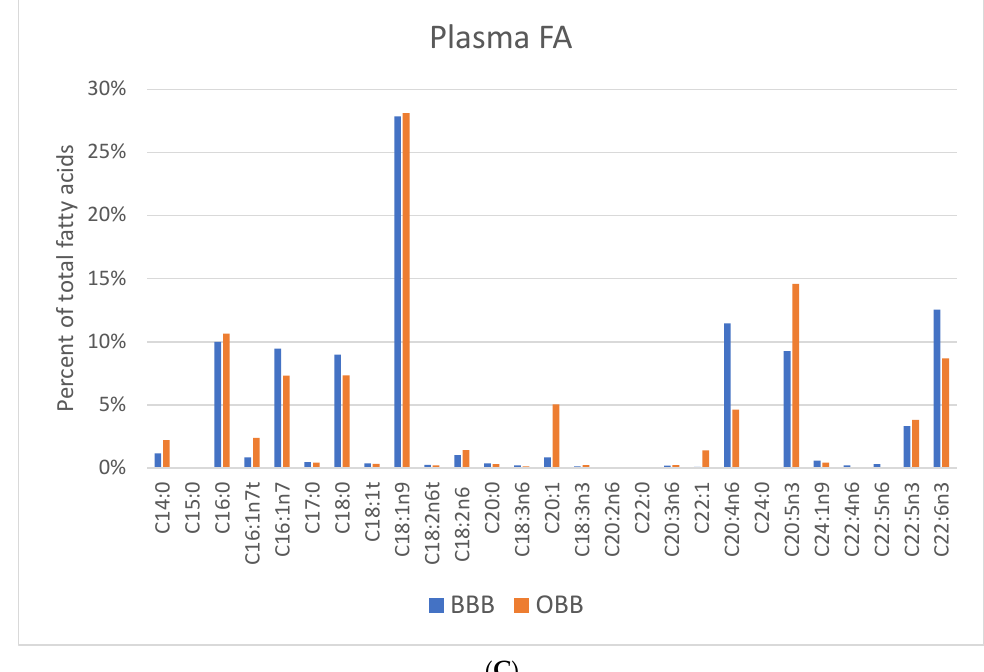
Figure 1. FA profiles for ( A ) RBC, ( B ) Whole blood (WB), and ( C ) plasma for Bristol Bay belugas (BBB, n = 9) and oceanaria-based belugas (OBB, n = 14). Data are expressed as a percent of total FAs. * p > 0.05 between groups. O3I, Omega-3 Index only applies to RBC EPA + DHA and has not been validated in WB, plasma or blubber.